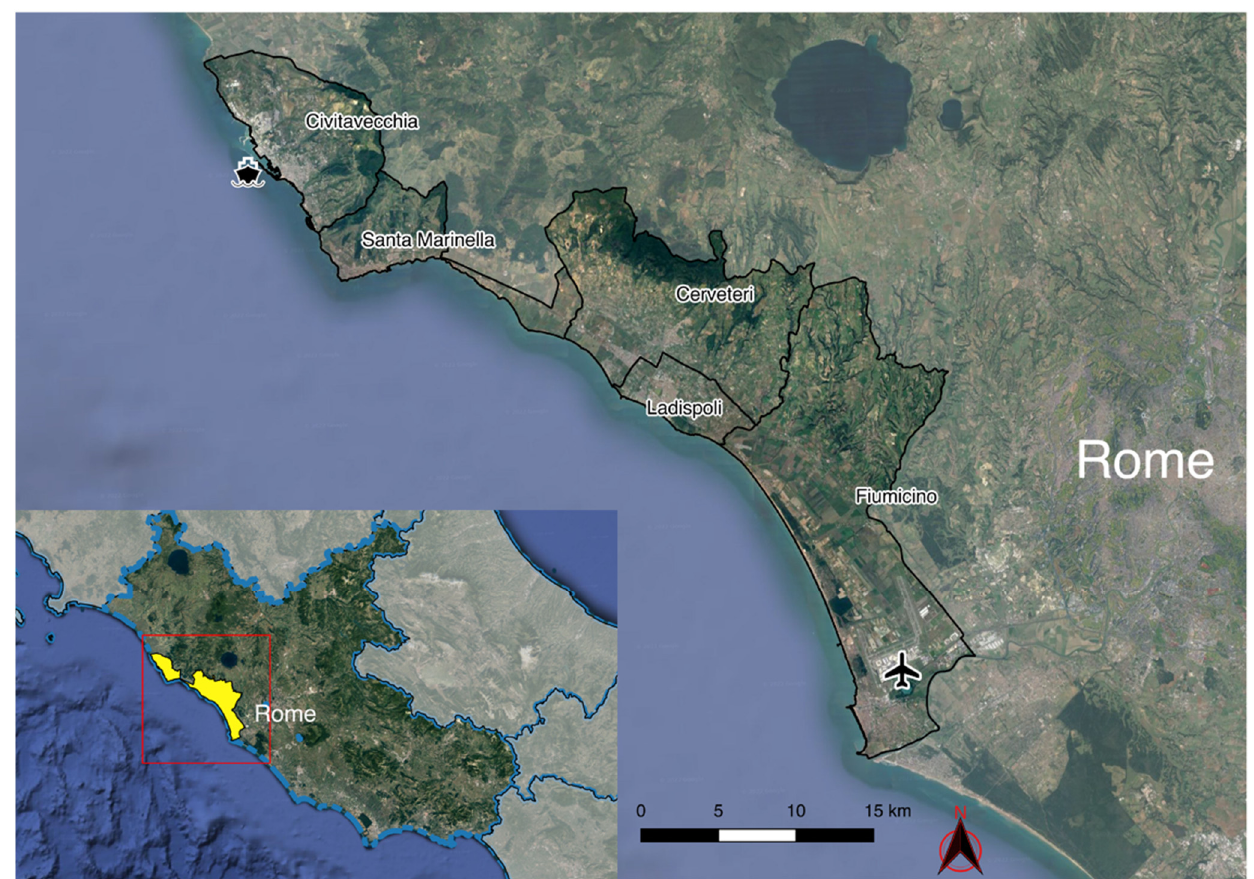
Figure 1. The geographic location of the five municipalities. In the bottom left: location of the survey area in central Italy, the area of interest (AOI) is highlighted in yellow.